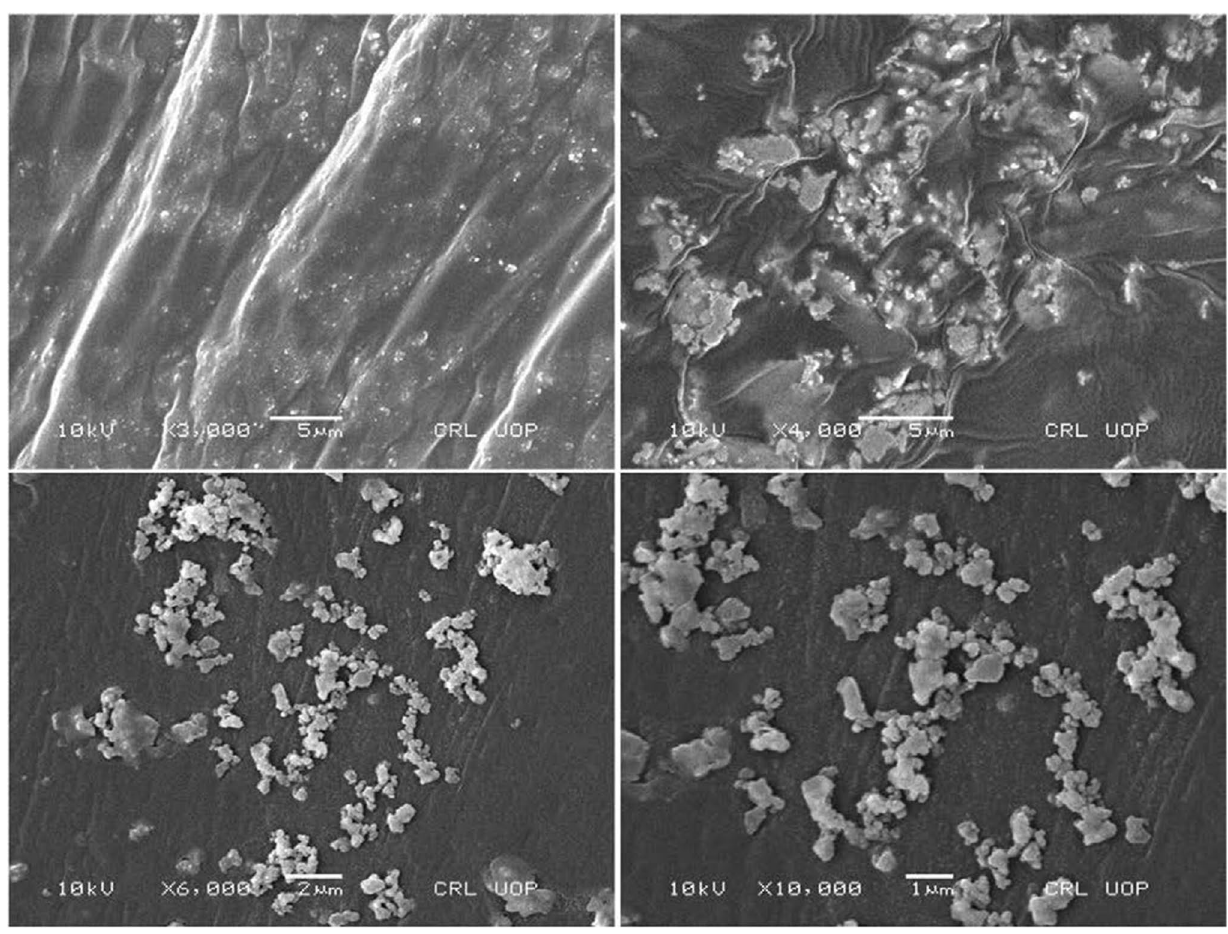
Fig. 3 SEM images of Co/cross-linked chitosan at different